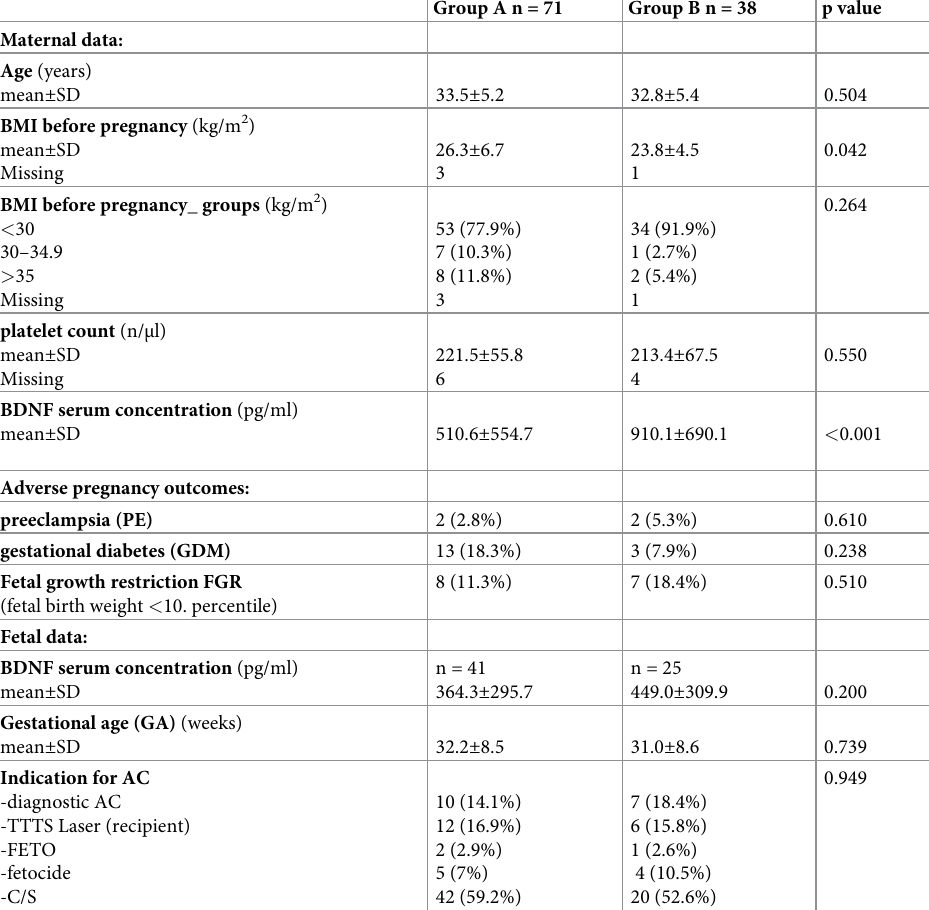
Table 1. Maternal, fetal and sample processing data of group A (AF-BDNF not detectable) and group B (AF-BDNF detectable), (n =